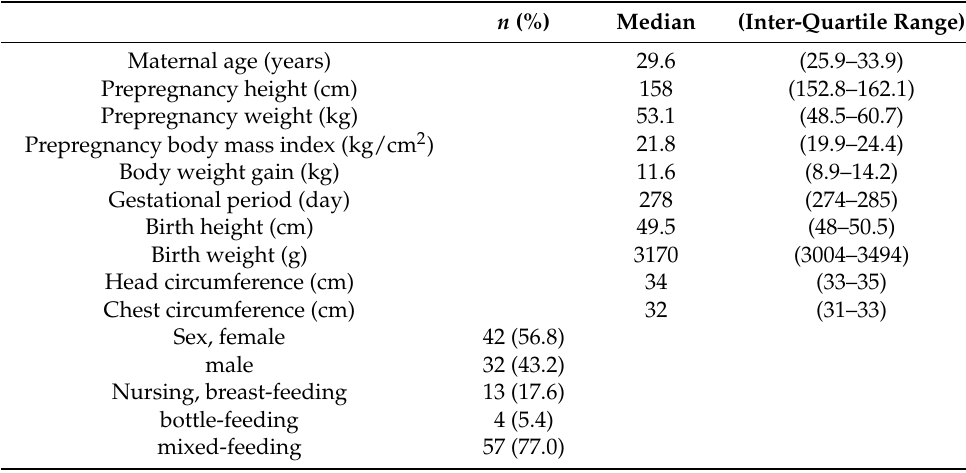
Table 1. Characteristics of the study population ( n =